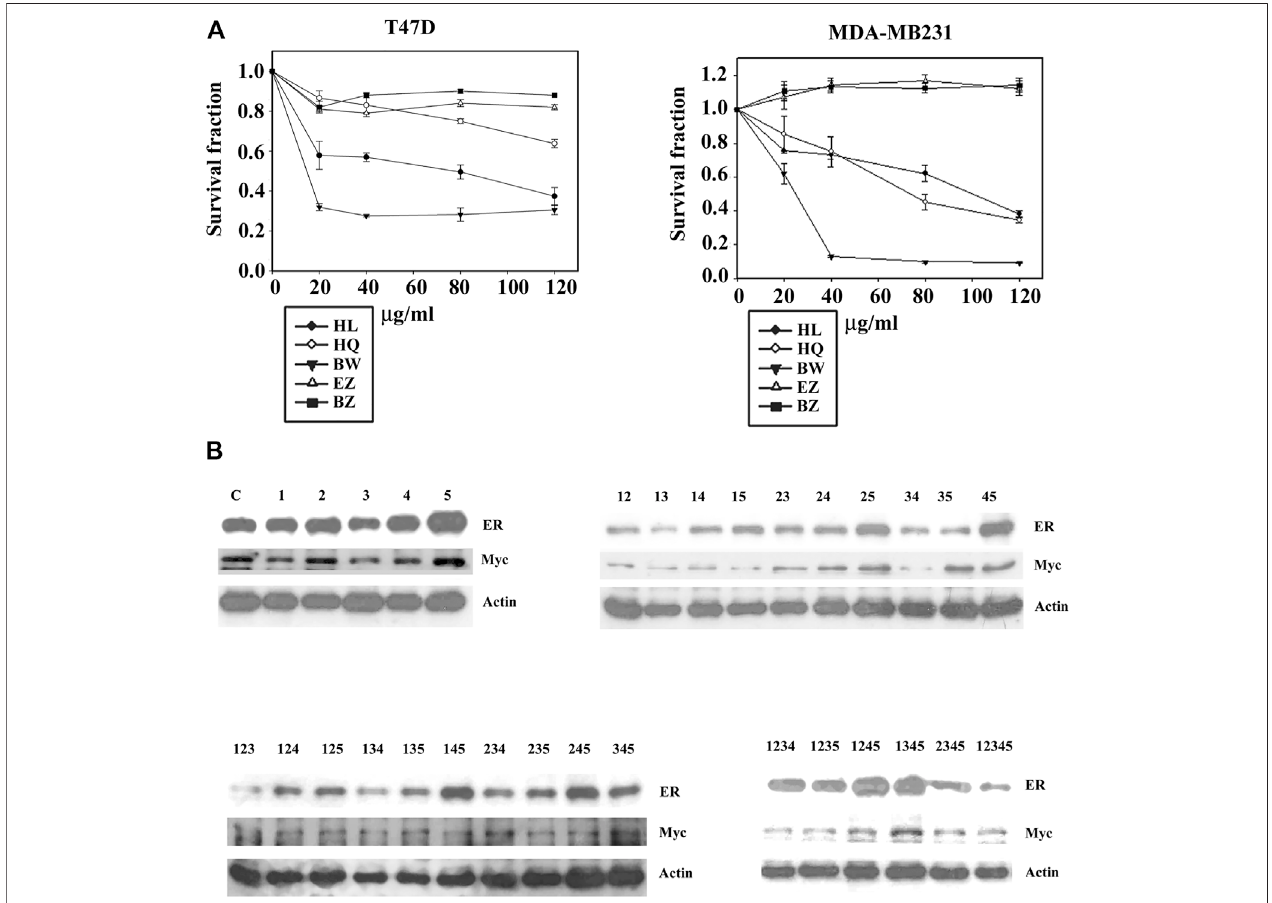
FIGURE4| Deconstruction ofFormulaX. (A) T47DandMDA-MB231 cellsweretreatedwithvariousdoses ofeach single component ofFormulaX(FX) for4 days. The level of surviving cells was determined by MTT assay. The survival fraction showed the fold change relative to the levels observed in the untreated control. The data arepresentedasthemean±SD. (B) T47Dcellsweretreatedwith40 μ g/mlofeachsingleorallpossiblecombinationsamongthe fi vecomponentsofFormulaXfor24 h. Western blotting analysis was used to characterize the effect of each treatment on the level of the indicated protein. 1) HL, 2) HQ, 3) BW, 4) EZ, 5) BZ.